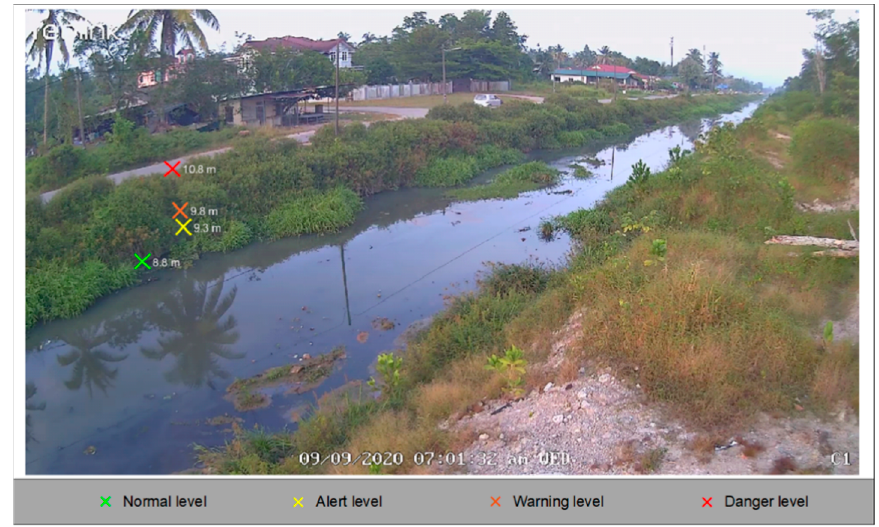
Figure 5. Water level markers were extracted from LiDAR data during normal conditions.